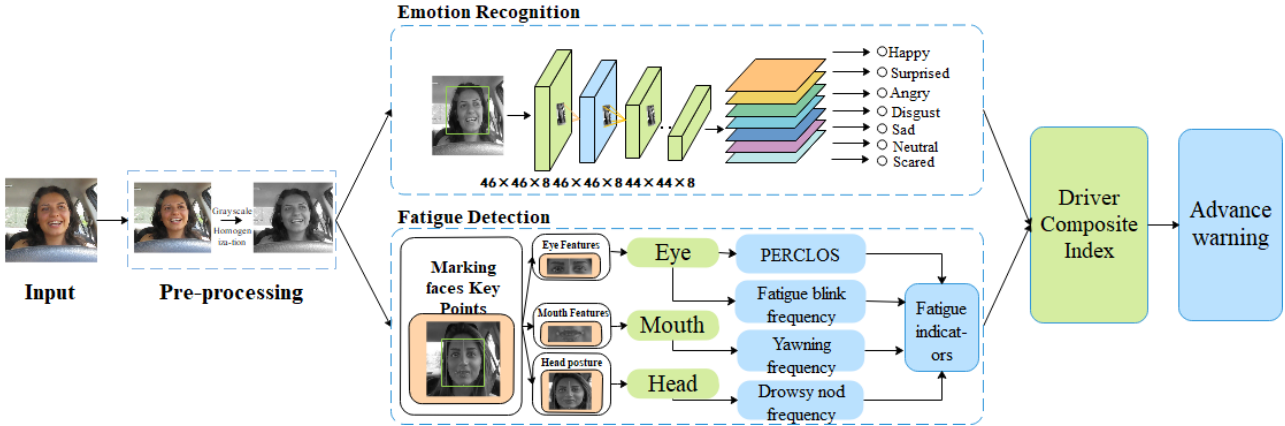
Figure 1. System architecture block